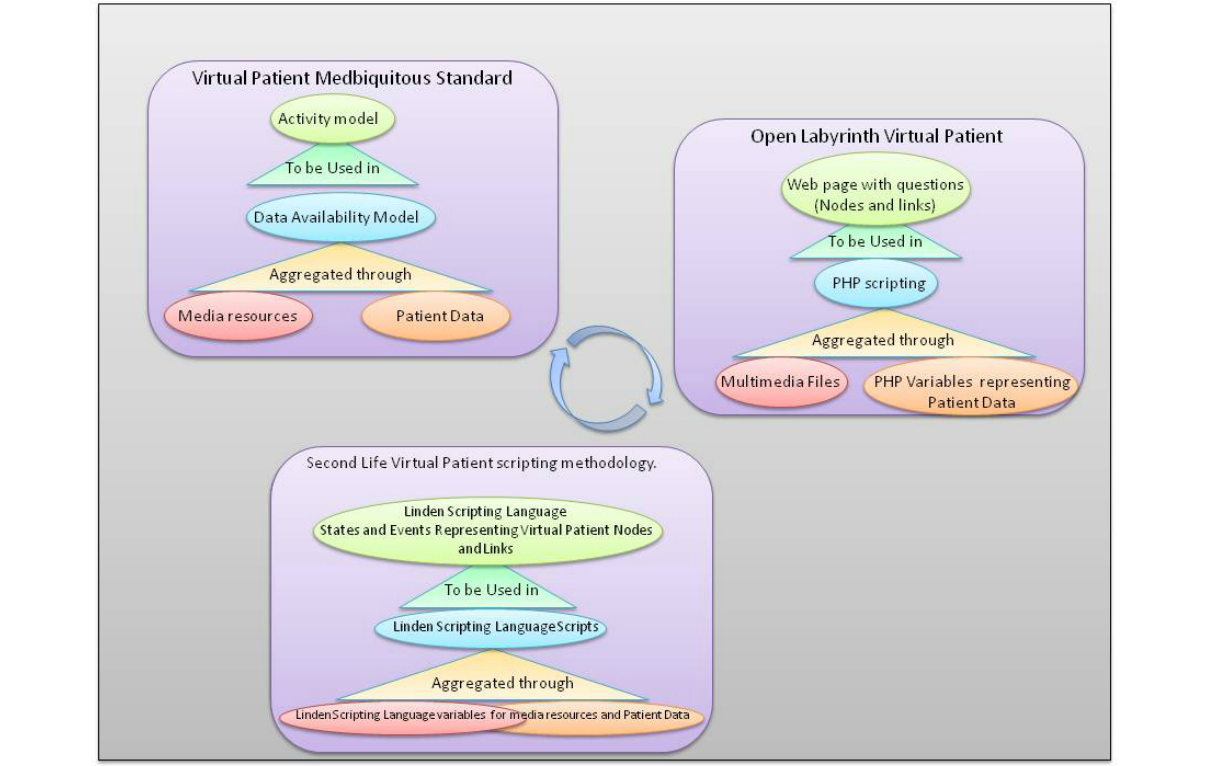
Figure 5. Design analogies: Second Life (SL) scripting paradigm, OpenLabyrinth deployment paradigm, MedBiquitous Virtual Patient Standard. PHP: Hypertext